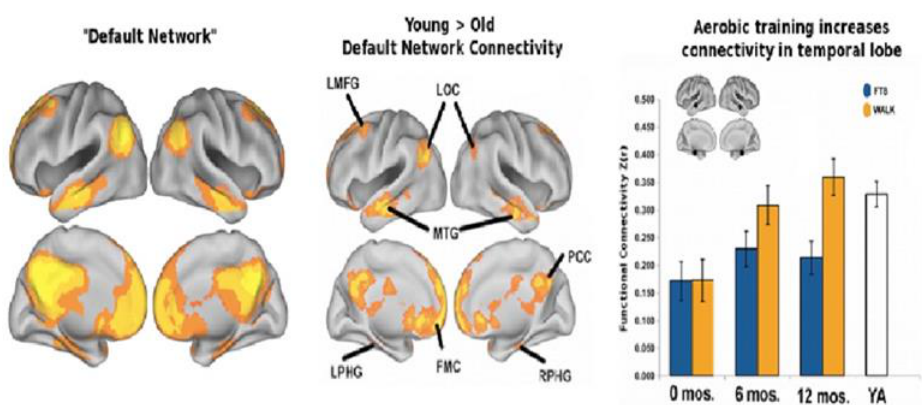
Figure 6. The left-hand panel represents the “default network” (DN) in healthy students of college age. The aging process has negative effects on network interconnectivities represented in the middle panel in particular within a major regional hub that involves the posterior cingulate. In contradistinction, the righthand panel inter-region connectivities (synchronous activity) of the DN following a one-year of aerobic exercise program in comparison to the non-aerobic control group. Walkers after a year demonstrated interregional connectivities not significantly different than college aged young adults (YA) (with permission [80]).